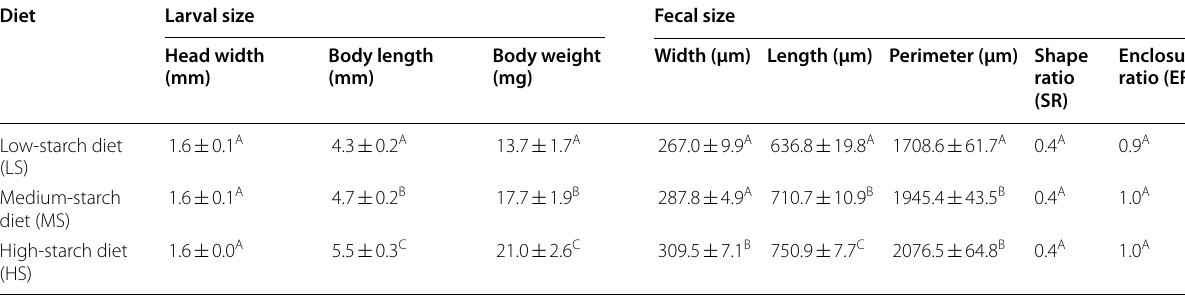
Different letters (A, B and C) indicate significant differences among the diet treatments (Tukey HSD test, p < 0.05)